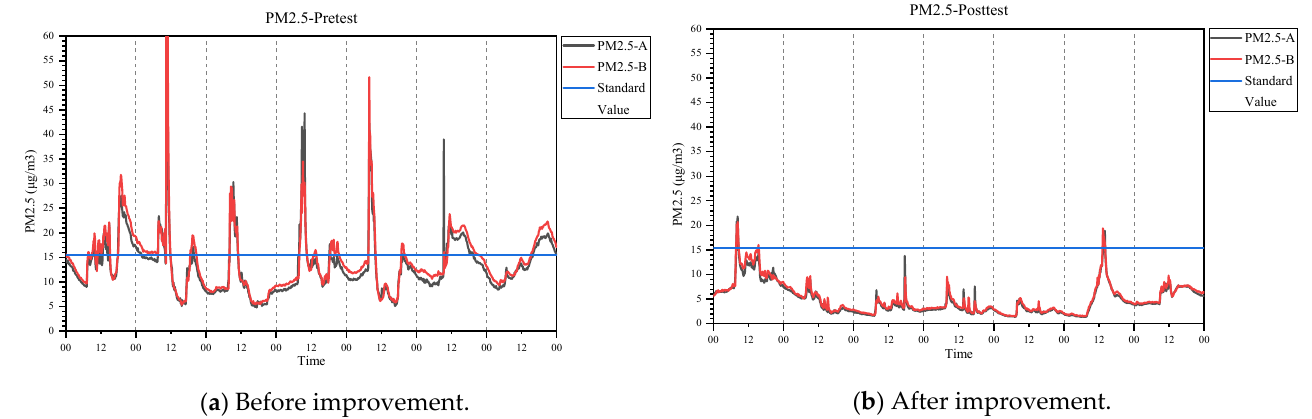
Figure 6. Comparison of indoor PM 2.5 concentrations before and after implementation of the im- provement plan.